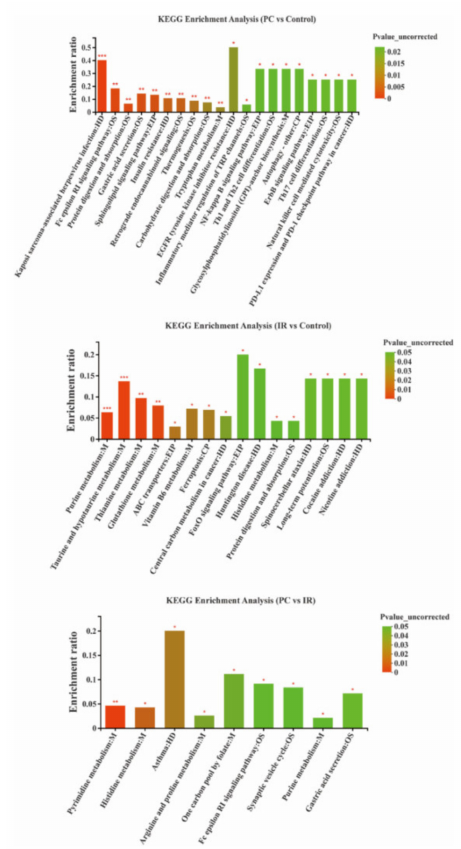
Figure 5. Metabolic pathway enrichment study of differentially presented metabolites between PC and control groups, IR and control groups, and PC and IR groups. CP, EIP, HD, M, and OS are the class names of the metabolic pathways in the KEGG annotation. CP: cellular processes; EIP: environmental information processing; HD: human diseases; M: metabolism; OS: organismal systems. * p < 0.05, ** p < 0.01, and *** p <